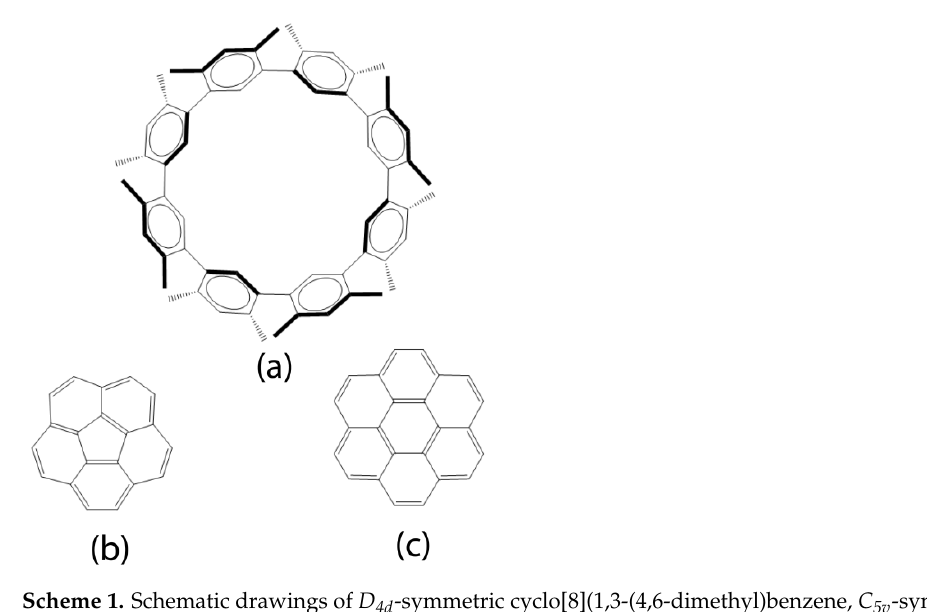
Scheme 1. Schematic drawings of D 4d -symmetric cyclo[8](1,3-(4,6-dimethyl)benzene, C 5v -symmetric corranulene, and D 6h -symmetric coronene in panels ( a ), ( b ), and ( c ), respectively. Table 1. The breakdown of contributions to ∆ E ABCD tetramer (in kJ/mol) defined in Equation (2). Interaction ∆ E ABCD CDMB . . . Cora